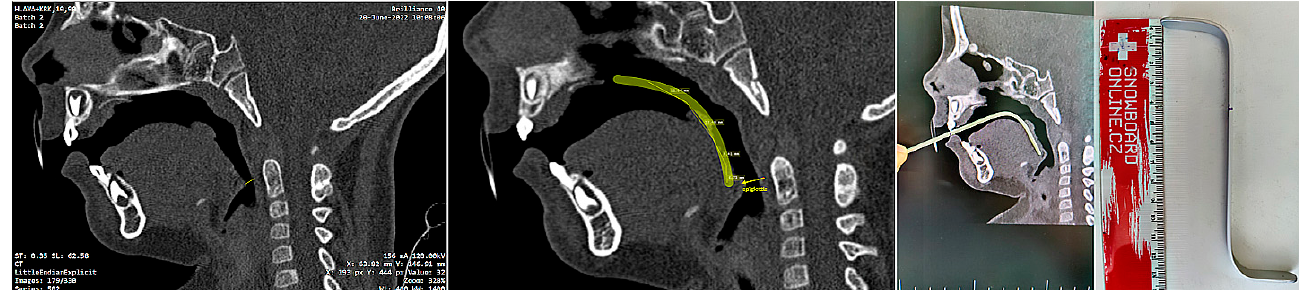
Figure 7. Example of a legacy CT utilization by a pediatric otorhinolaryngology department in an effort to provide instructions for orthodontists and dental laboratories for the approximate ideal length and angulation of the spur. CT/CBCT examination of the patients is not necessary to identify the morphology and relationships of the soft tissues, although it can be successfully utilized for the 3D design of the appliance.